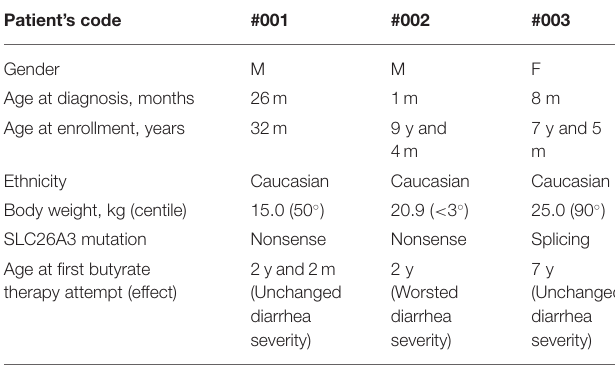
TABLE 1 | Baseline features of previous unresponsive to butyrate therapy CLD